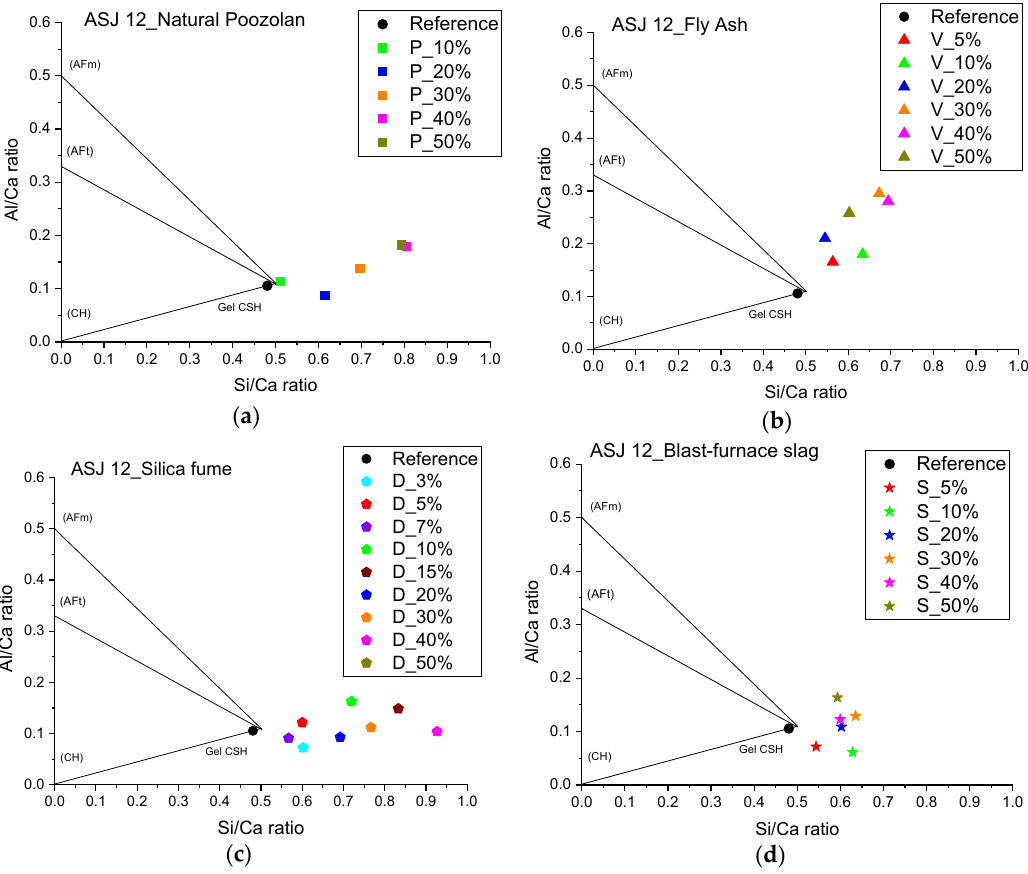
Figure 12. Relation between the Si/Ca ratio and the Al/Ca ratio of mortars made with the high-reactive siliceous pebble, ASJ_12, and four additions mixed in different percentages after 90 days of testing: ( a ) natural pozzolan, P; ( b ) siliceous coal fly ash, V; ( c ) silica fume, D; ( d ) blast-furnace slag, S. It is noted that the composition of C-S-H gel has a Si/Ca ratio ranging from 0.5 to 0.95. In particular, the values of Si/Ca ratio for the natural pozzolan pastes range from 0.5 to 0.8, for the fly ash pastes from 0.6 to 0.7 and for blast-furnace slag pastes from 0.55 to 0.65. Conversely, pastes with silica fume have much higher ratios, up 0.95. This is due to the high Ca(OH) 2 consumption during